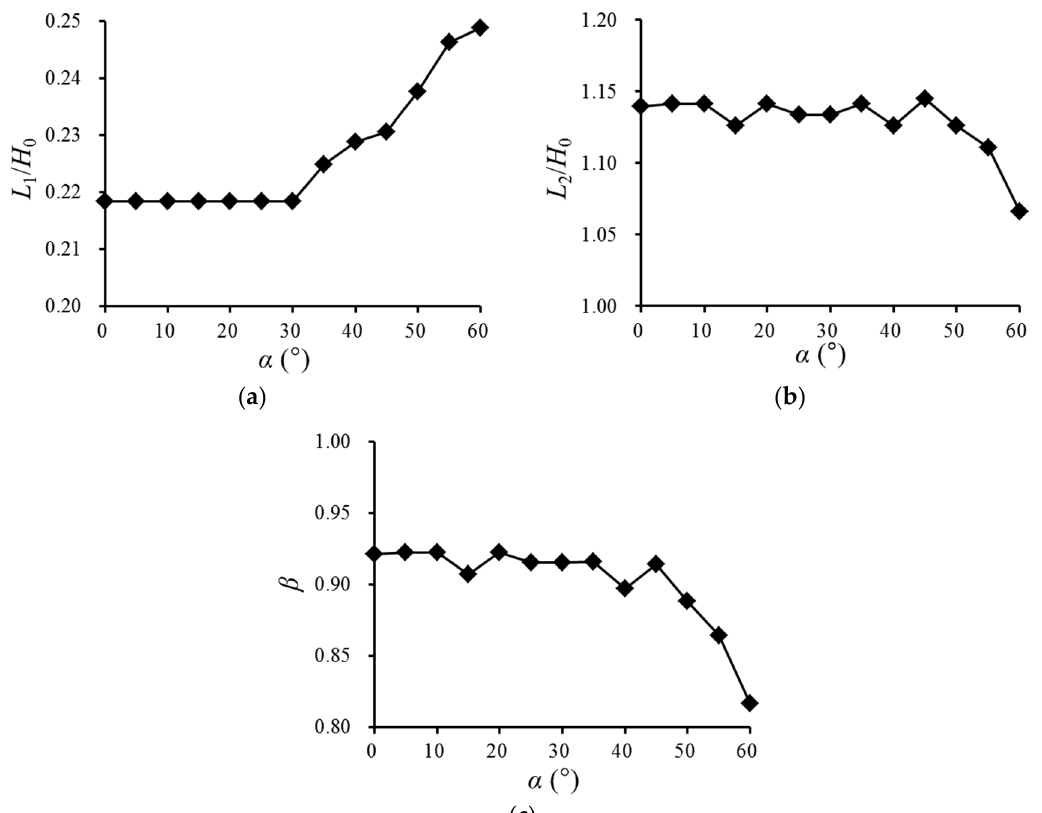
α on free jet length ( a ): L